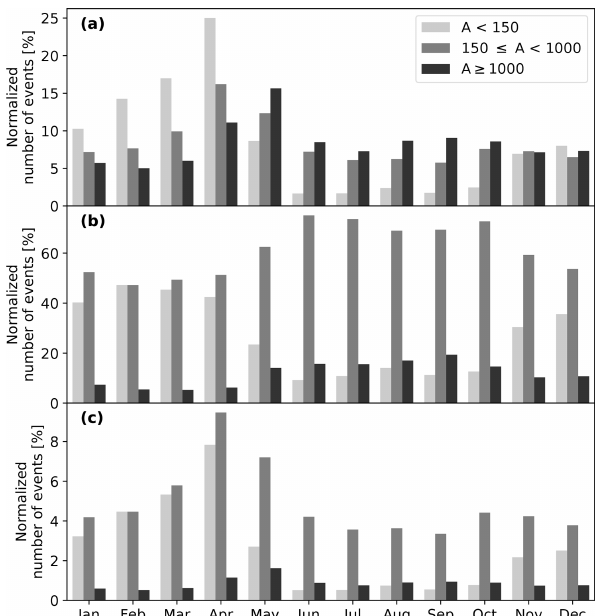
Figure B15. Histogram showing the distribution of events of lower amplitude (light grey), intermediate amplitude (grey), and higher ampli- tude (dark grey) over months. The number of events is normalized in (a) by the total number of events in the different amplitude ranges, in (b) by the total number of events per month, and in (c) by the total number of events in the dataset. The deficit in low-amplitude events from June to October is particularly visible in all cases. A seasonal variation in the proportion of intermediate and high-amplitude events exists as well but to a much lesser